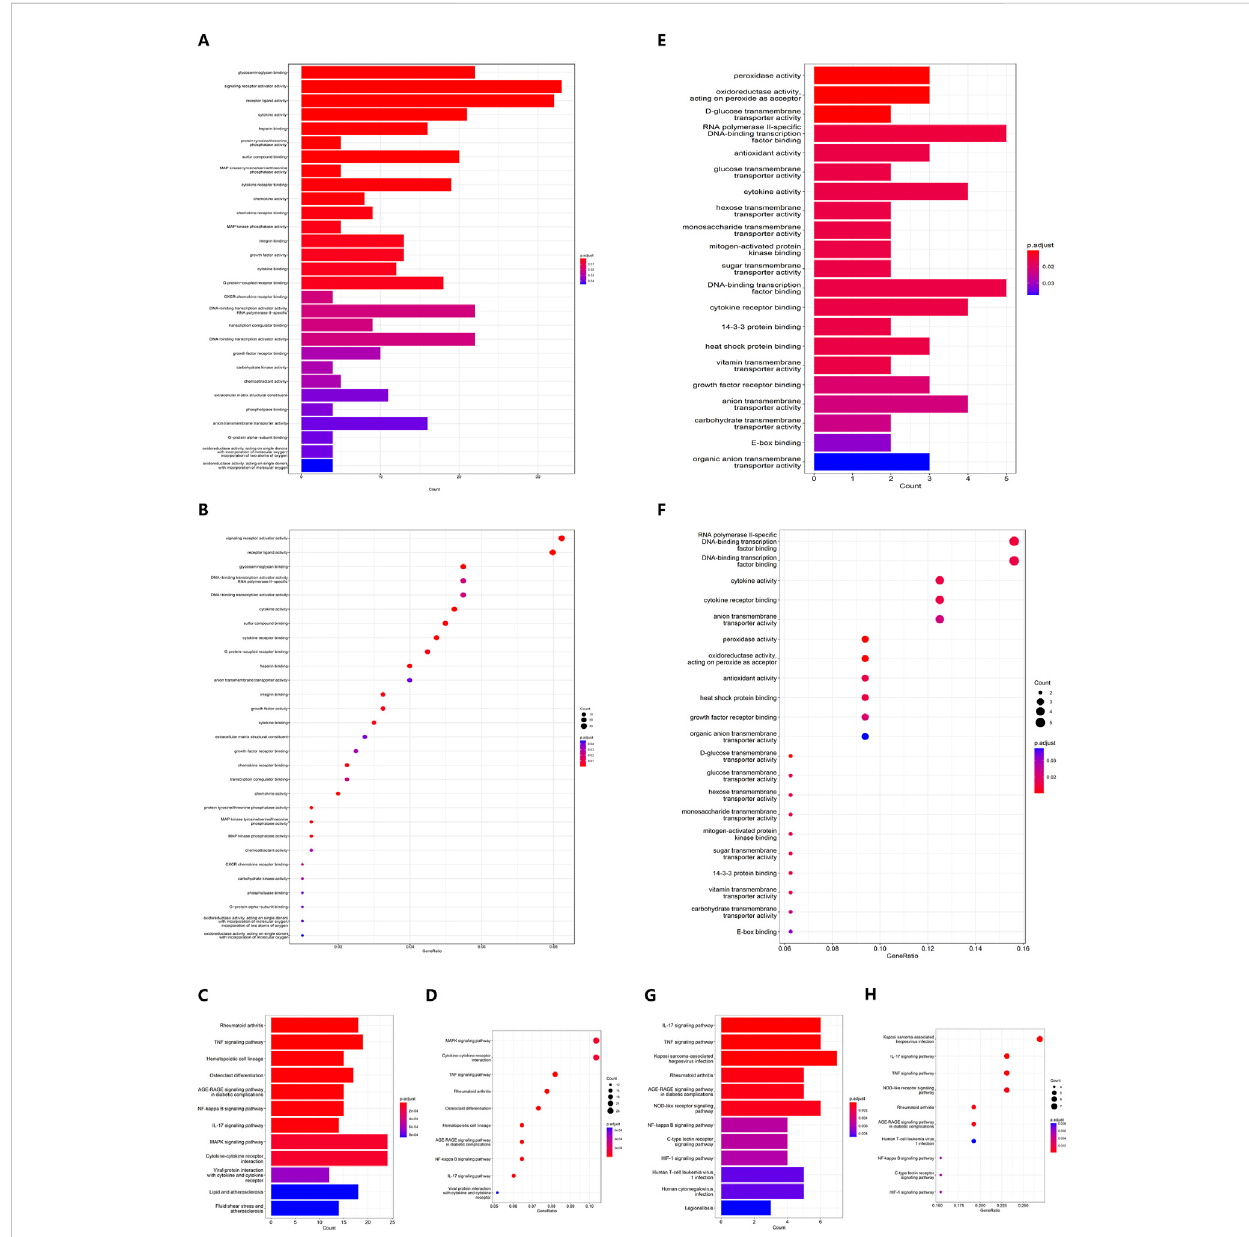
FIGURE 3 (A) Barplot and (B) Bubble plot of DEG GO enrichment analysis. (C) Barplot and (D) Bubble plot of DEG KEGG pathway enrichment analysis. (E) Barplot and (F) Bubble plot of DFG GO enrichment analysis. (G) Barplot and (H) Bubble plot of DFG KEGG pathway enrichment